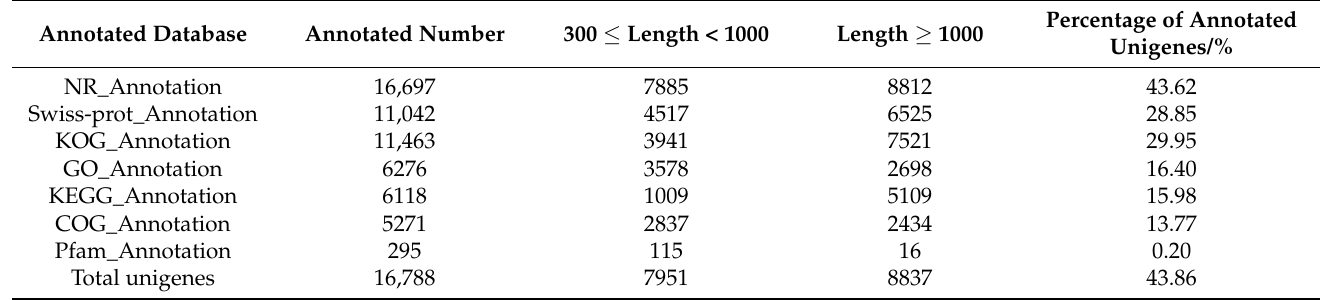
Table 1. Functional annotation of the unigenes associated with the antennae of female O. loti and recovered from seven databases.